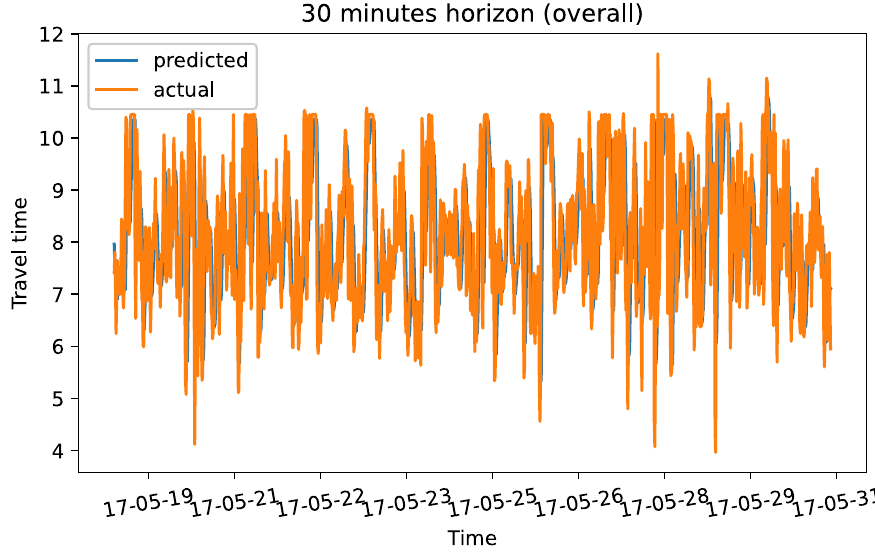
Fig 8. Prediction results for 30 minutes horizon on test data